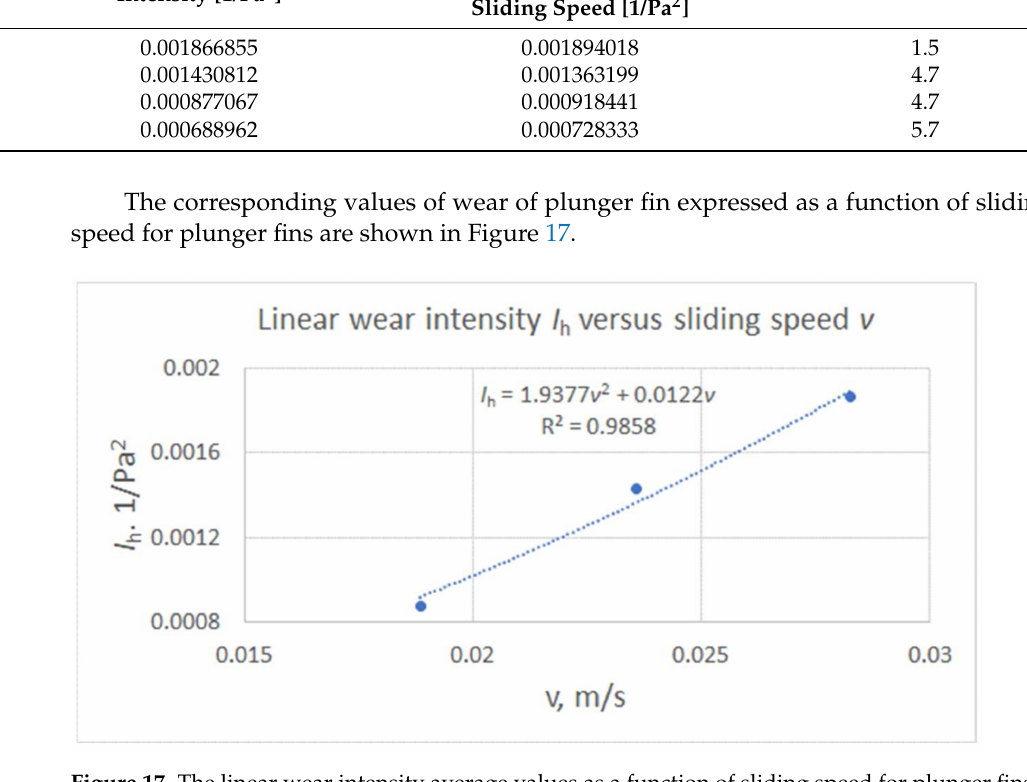
Figure 17. The linear wear intensity average values as a function of sliding speed for plunger